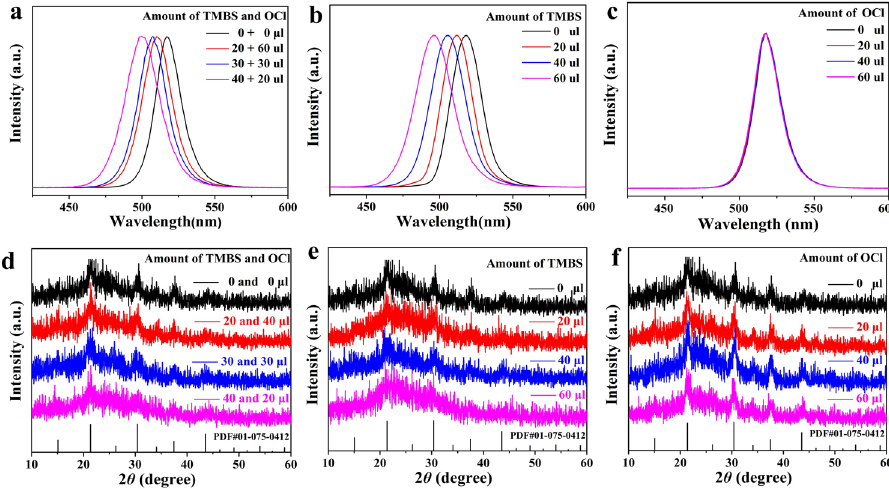
Figure 6. ( a – c ) The PL spectrum of diverse CsPbBr 3 @HSNSs-Grafted and ( d – f ) their corresponding Figure 6. ( a , b , c ) The PL spectrum of diverse CsPbBr 3 @HSNSs-Grafted and ( d , e , f ) their corre- XRD sponding XRD spectra.